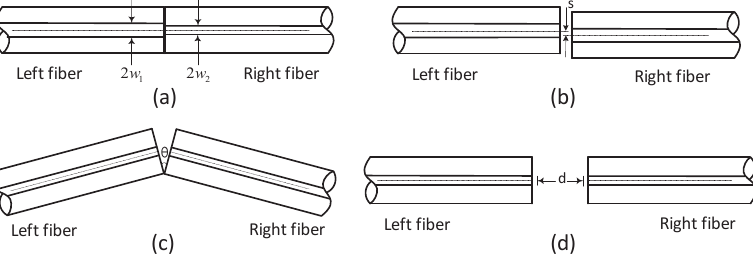
Figure 3. The main factors of fusion-splicing loss, ( a ): MFD mismatch, the mode field diameters of the left and right fibers are 2 w 1 and 2 w 2 ( µ m) respectively; ( b ): lateral offset, the two optical fiber end faces are laterally offset by s ( µ m); ( c ): angle tilt, the end faces of the two fibers are tilted by θ degrees; ( d ): end face gap, the end faces of the two optical fibers are d ( µ m)